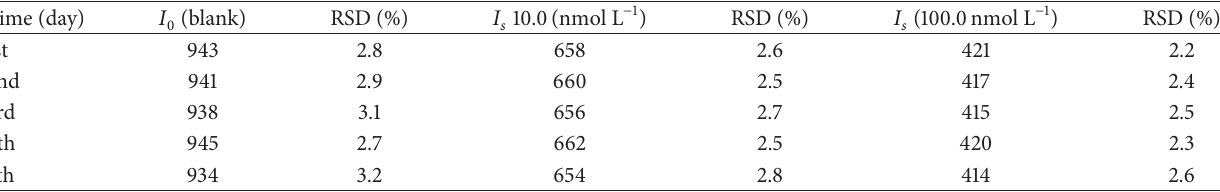
Table 1: Stability and reproducibility test of the FI-CL system for UA determination a .